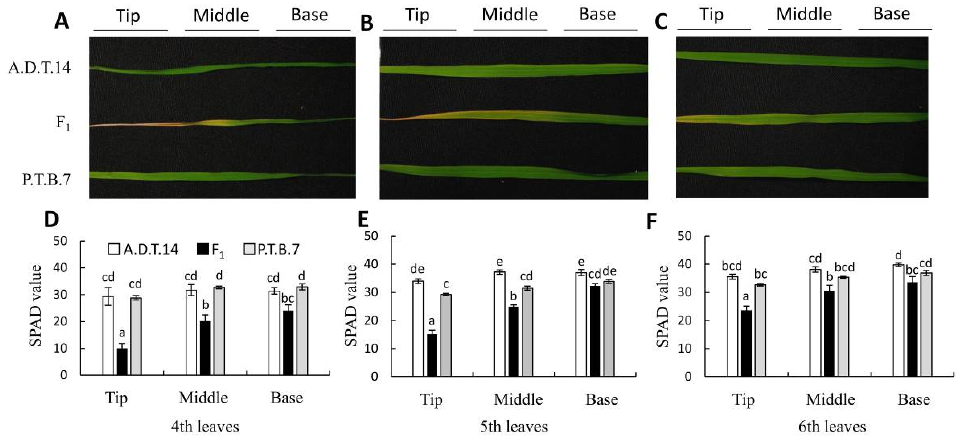
Figure 3. Phenotypes and SPAD values of leaves (fourth to sixth) from parental and F 1 hybrid rice. The phenotypes ( A – C ) and SPAD values ( D – F ) of fourth ( A , D ), fifth ( B , E ), and sixth ( C , F ) leaves were assessed at 60 days after sowing. SPAD value was measured at the tip, middle, and base of each leaf. Values and error bars indicate mean ± SE values ( n = 3). Different lowercase letters in each plot ( D – F ) indicate significant differences (Tukey HSD test, P < 0.05).